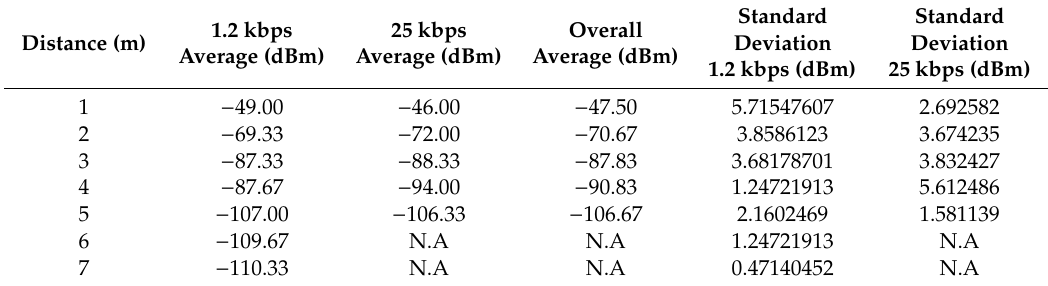
Table 1. Results from field work with averages for the 1.2 kbps, 25 kbps and the overall average, where applicable.